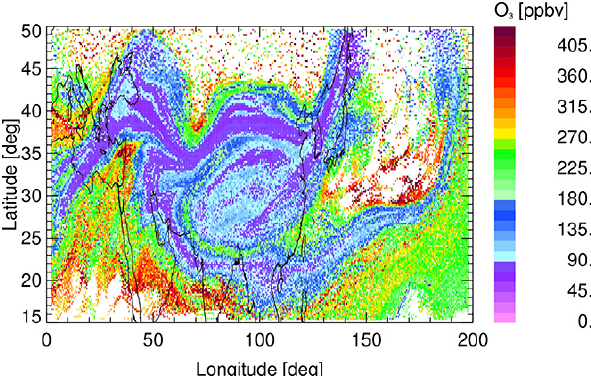
Figure 10. Ozone distribution in the upper part of the Asian mon- soon anticyclone (about 18km) for 9 August 2003 as simulated by the CLaMS model with a horizontal resolution of around 25km. The Asian monsoon has a strong influence on the composition of the tropical tropopause region (TTL). “Young” tropospheric air (low ozone) results from fast convective upward transport in the centre of the Asian monsoon. Quasi-horizontal mixing of older extratropical stratospheric air (high ozone values) into the TTL occurs at the edge of the highly variable